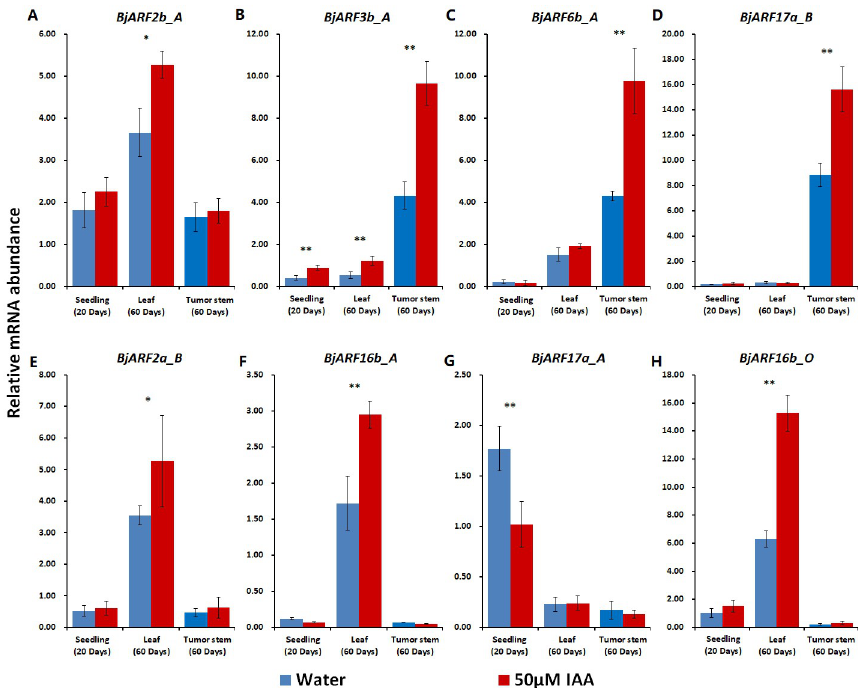
Fig 8. Fold induction of BjARF genes in response to exogenous auxin. For B . juncea Yonganxiaoye 1, 20-day-old seedling and a 60-day-old leaf and tumor stem were collected following treatment with 50 μ M IAA and water as a control. Values represent the mean ± standard error of the mean (SEM). Paired-samples t -test (one-tail) for 50 μ M IAA treatment with a negative control to detect significant differences, �� p < 0.01 and � p < 0.05.